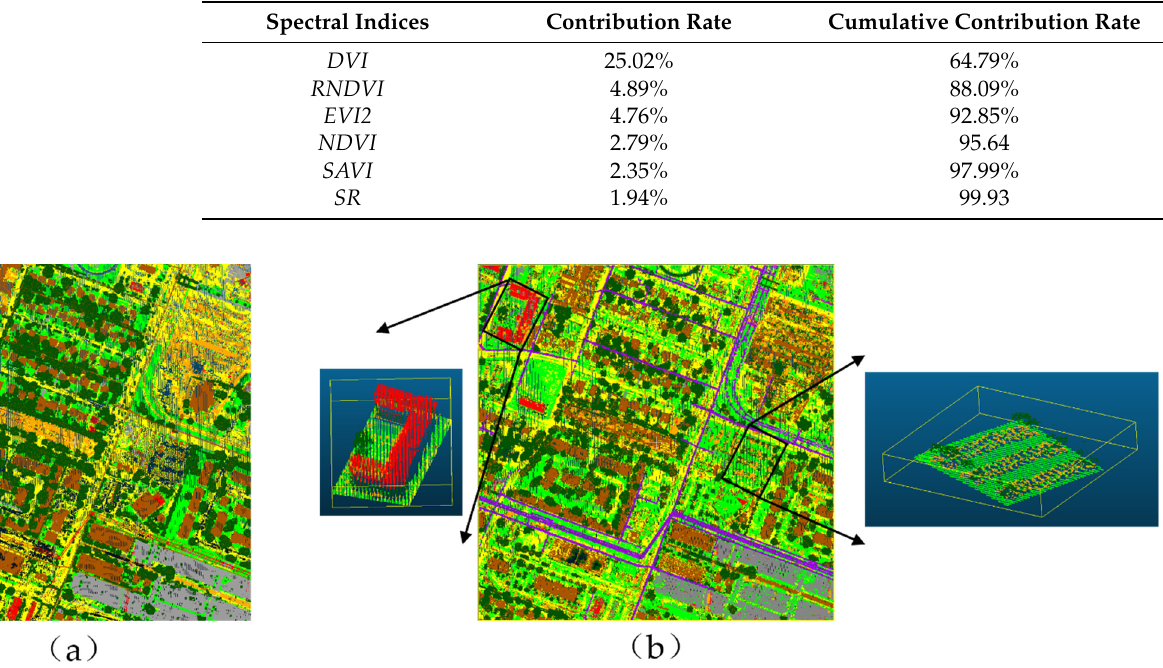
Table 7. The contributions of the spectral indexes.